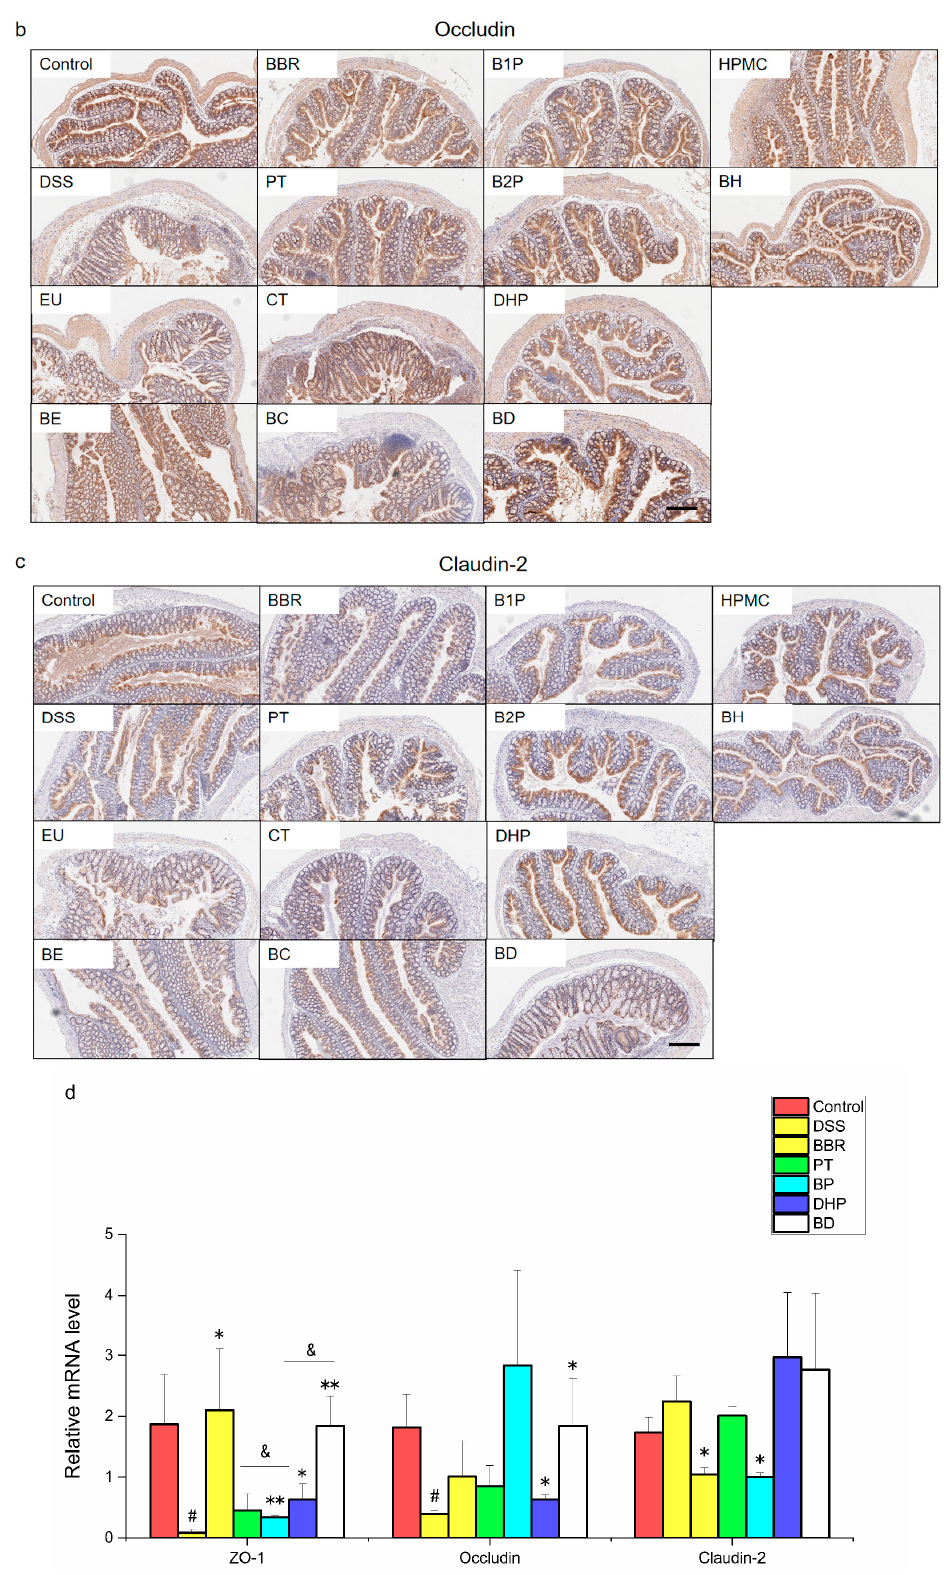
Figure 3. ( a – c ) Immunohistochemical staining of ZO-1, occludin, and claudin-2. ( d ) Colonic mRNA levels of ZO-1, occludin, and claudin-2. (Significance was assessed by using t -test, ns, not significant; # p < 0.05, compared with the control group; * p < 0.05, ** p < 0.01, compared with the DSS group; & p < 0.05, compared with the group combined with